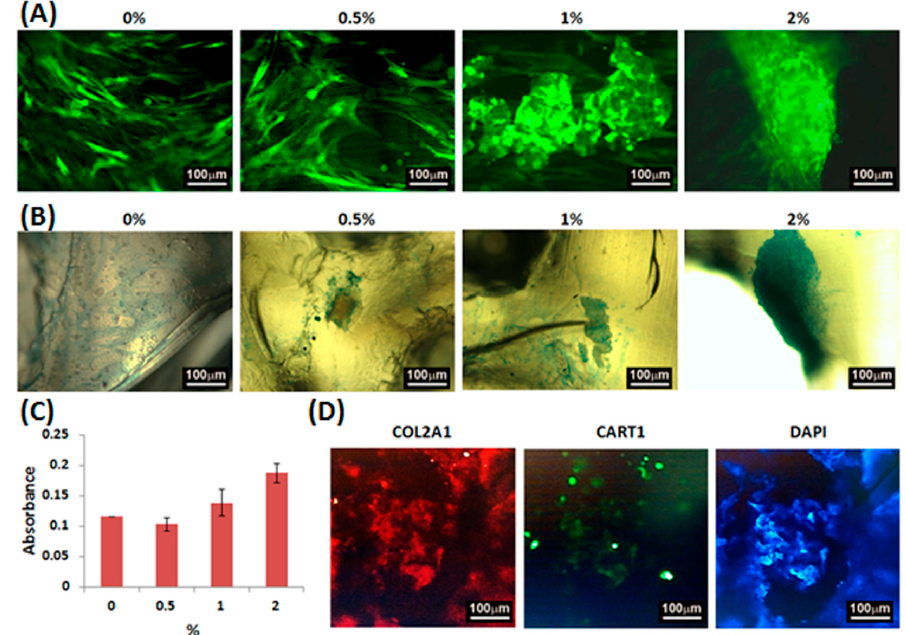
Figure 8. The ( A ) fluorescent and ( B ) Alcian blue staining images and the ( C ) GAG contents of the micromass cultures of WJMSCs cultured on PU/HA hybrid scaffolds for 1 day; ( D ) The immunofluorescence staining images of nuclei (blue), COL2A1 (red) and CART1 (green) for the micromass cultures of WJMSCs cultured on PU/HA hybrid scaffolds with 2% HA for 1 day.